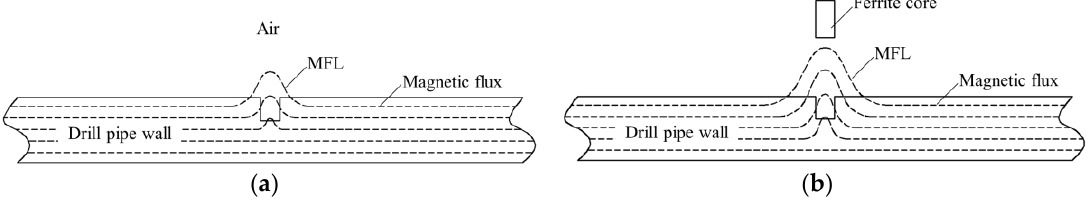
Figure 4. The principle of the lift-off-tolerant MFL sensing method based on the magnetic field focusing effect. ( a ) the MFL distribution without ferrite cores; ( b ) the MFL distribution with a ferrite core.